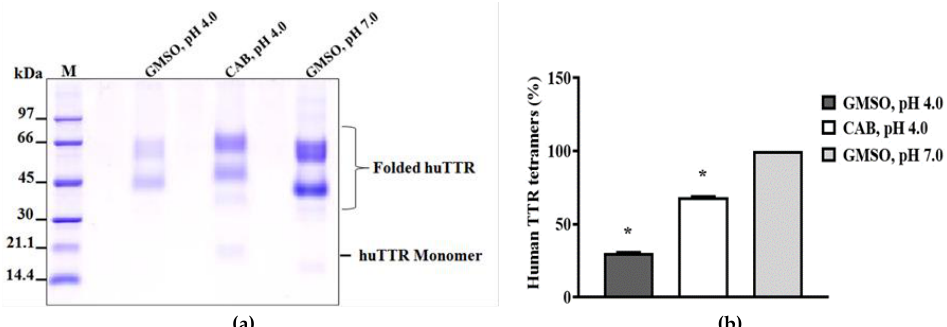
Figure 3. The resistance of human transthyretin in the absence or presence of CAB against acid-mediated denaturation. HuTTR (0.5 µg/µL) was incubated with or without CAB (50 µg/µL) and subjected to acidic denaturation conditions for 2 weeks. ( a ) The image represents the resolved protein mixtures on 10% Tricine SDS-PAGE gels after cross-linking with glutaraldehyde. M: Protein molecular weight marker; 1: huTTR with GMSO only, pH 4.0; 2: huTTR with CAB, pH 4.0; 3: huTTR with GMSO only, pH 7.0. ( b ) Bar chart represents the extent of huTTR stability, derived from the percentage of tetramers (%) left after denaturation. * values are significantly different at p < 0.05.